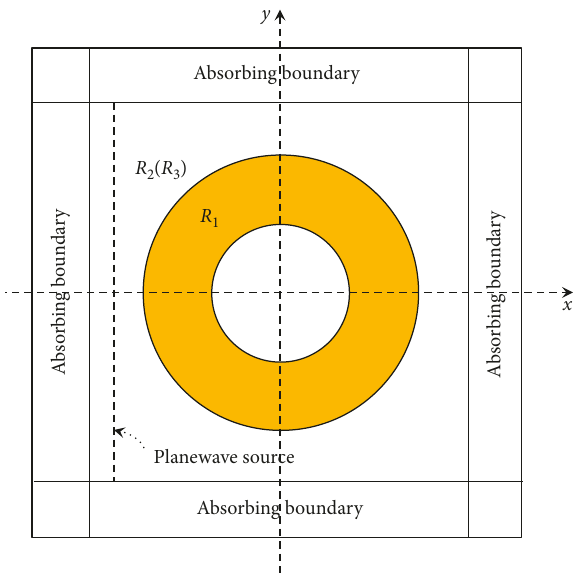
Figure 8: Two-dimensional FDTD analysis domain. A source was incident from the